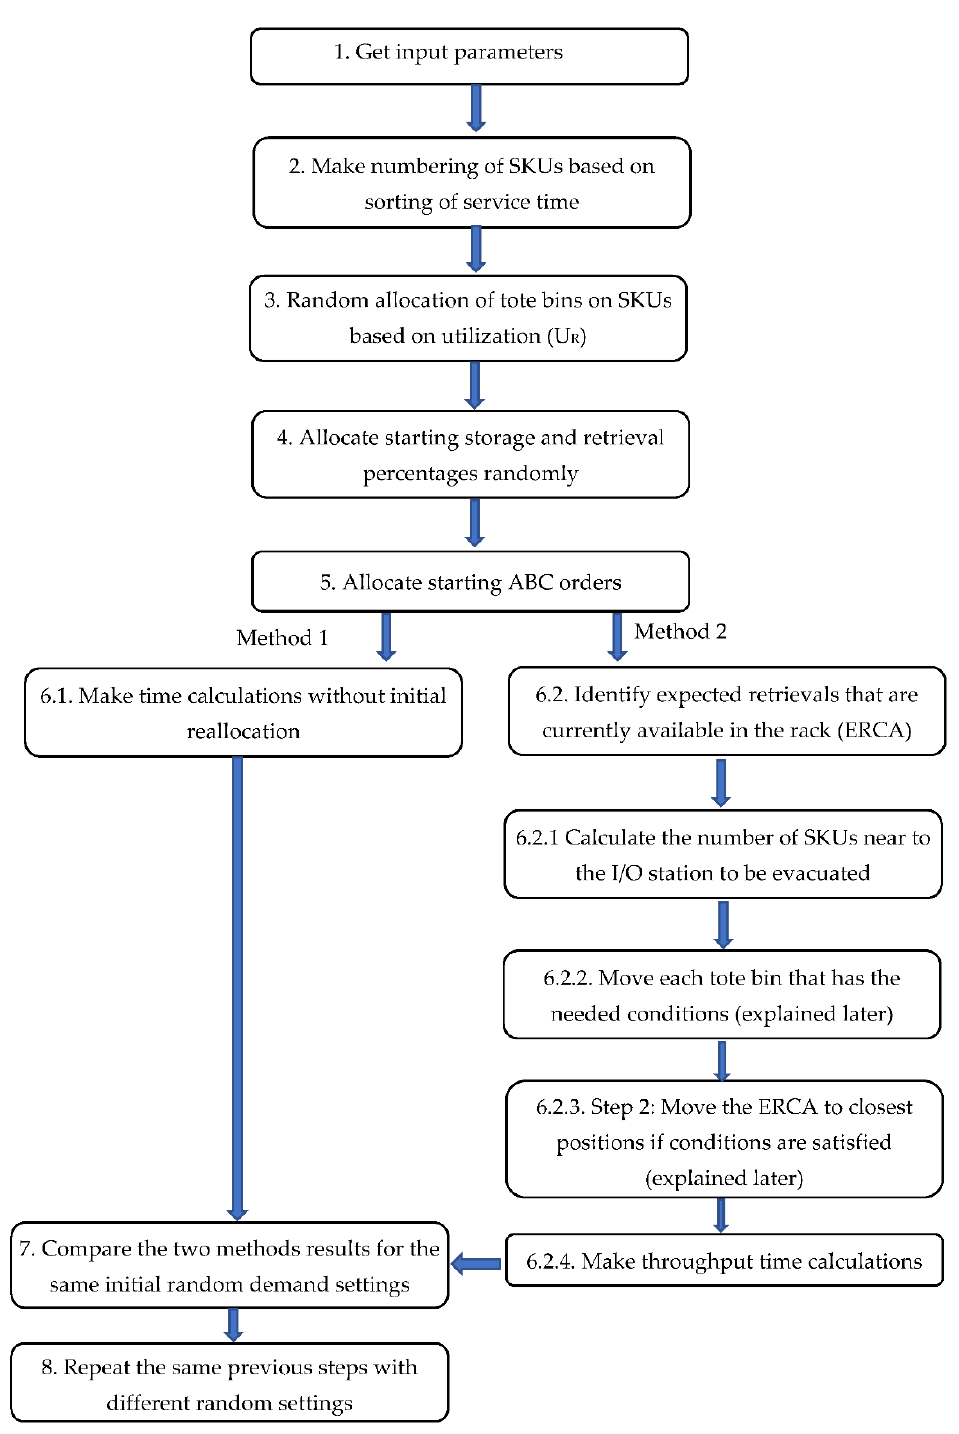
Figure 3. Process flow diagram for the study.